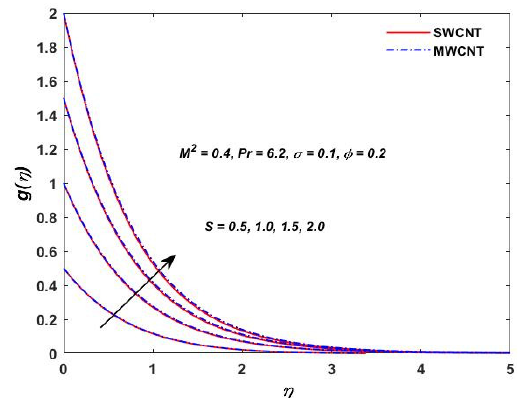
Figure 6. Rotation S verses velocity f (cid:48) ( η ) .